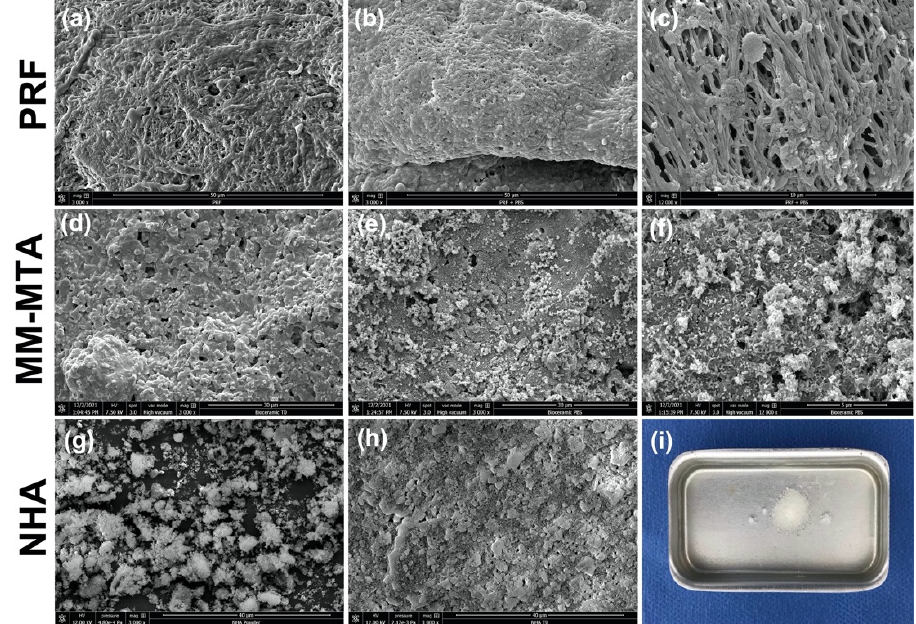
Figure 5. Representative scanning electron microscope images at 3000× magnification ( a , b , d , e , g , h ) and 12,000× magnification ( c , f ). The morphology observed for ( a ) PRF and ( d ) for MM-MTA and ( h ) NHA before immersion in PBS; ( g ) NHA powder; ( b , c ) the morphology observed for PRF, ( e , f ) for MM-MTA and ( i ) for NHA after immersion in PBS for 7 days at 37